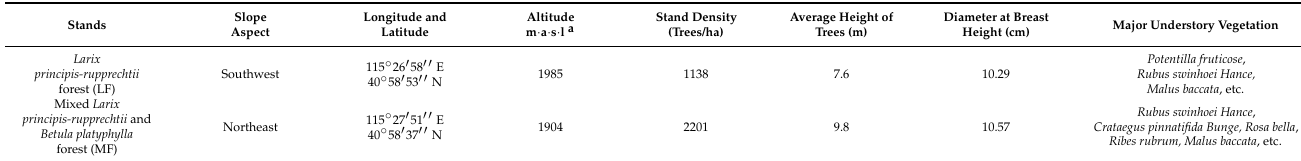
Figure 1. Location of the study site. Table 1. The basic situation of the sample plots in the study site.